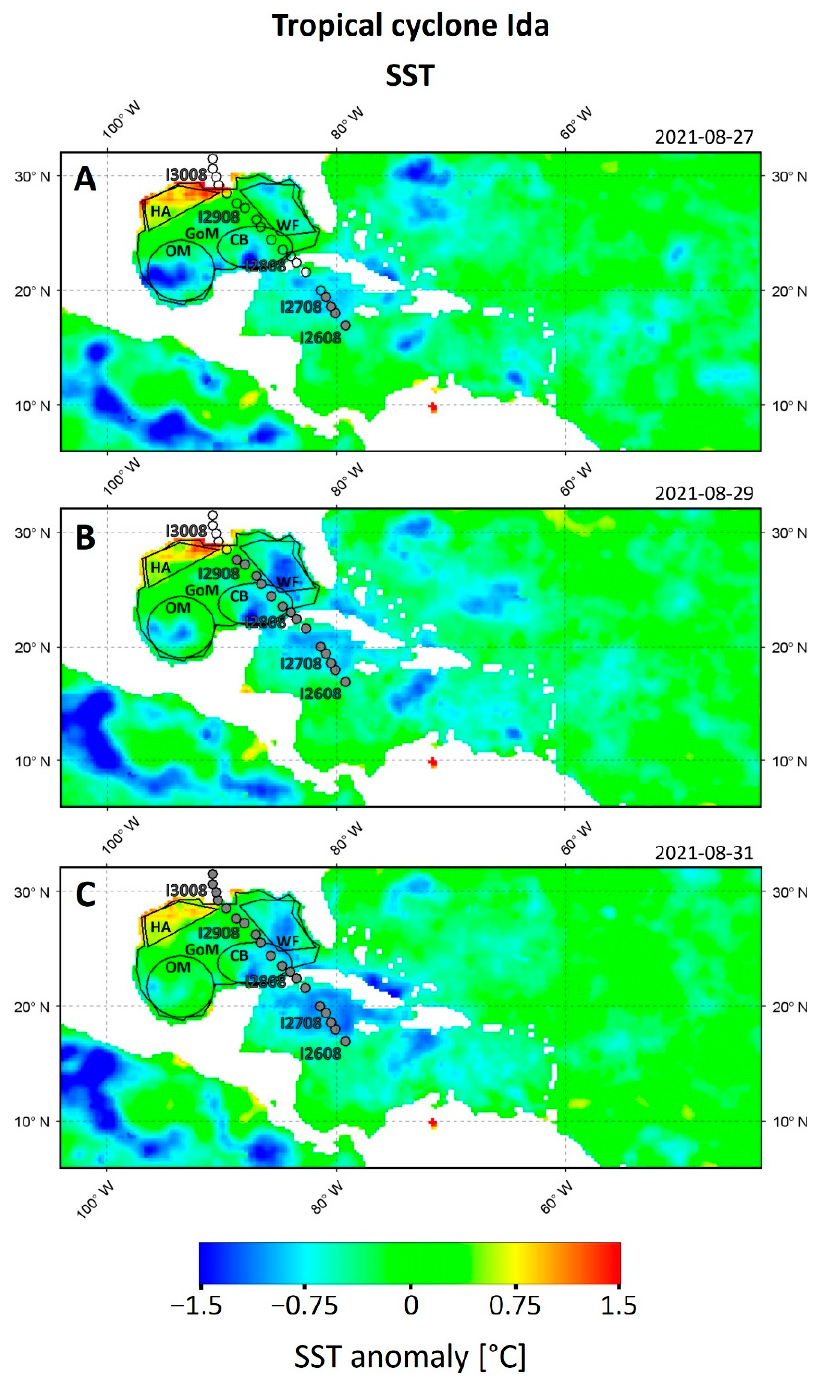
Figure 2. Anomaly maps for SST in the study area of TC Ida for ( A ) 27 August 2021, ( B ) 29 August 2021 and ( C ) 31 August 2021. Anomalies are color-coded as indicated by the color bar. Tracks are marked with circles, where open circles indicate that the storm has not yet passed the position yet. The labels along the track indicate position of Ida (I) on a particular day and month, e.g., I2608. The dates of the satellite images are given in the top right of each panel. White space indicates areas without data.